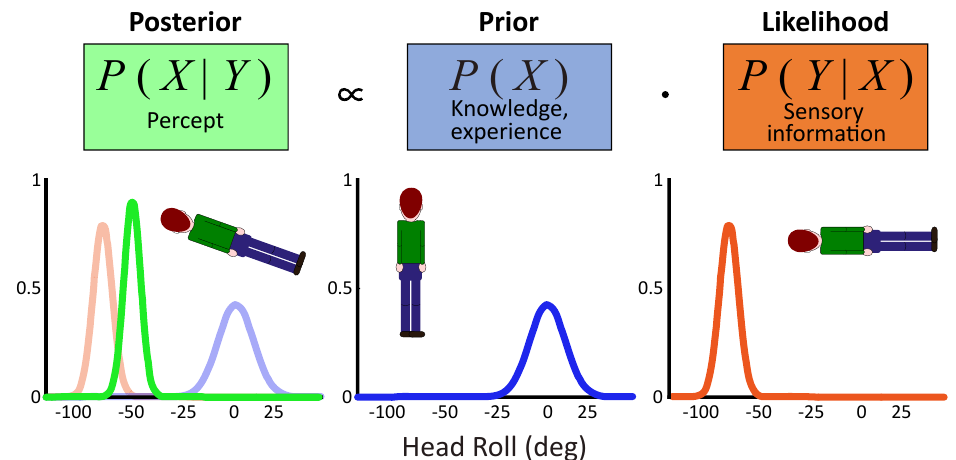
Figure 4. Representation of a simplified Bayesian model for the A-effect. The green curve describes the perceived head roll as a posterior probability distribution proportional to the product of the sensory information described by a likelihood function (orange curve) centered at the physical head roll (peak = − 90 ◦ ) and a prior distribution (blue curve) centered at the upright position (head roll = 0 ◦ ). The posterior (green curve) appears pulled toward the prior distribution (peak = − 50 ◦ ) and slightly narrower compared to the likelihood. All probabilities are assumed to be normally